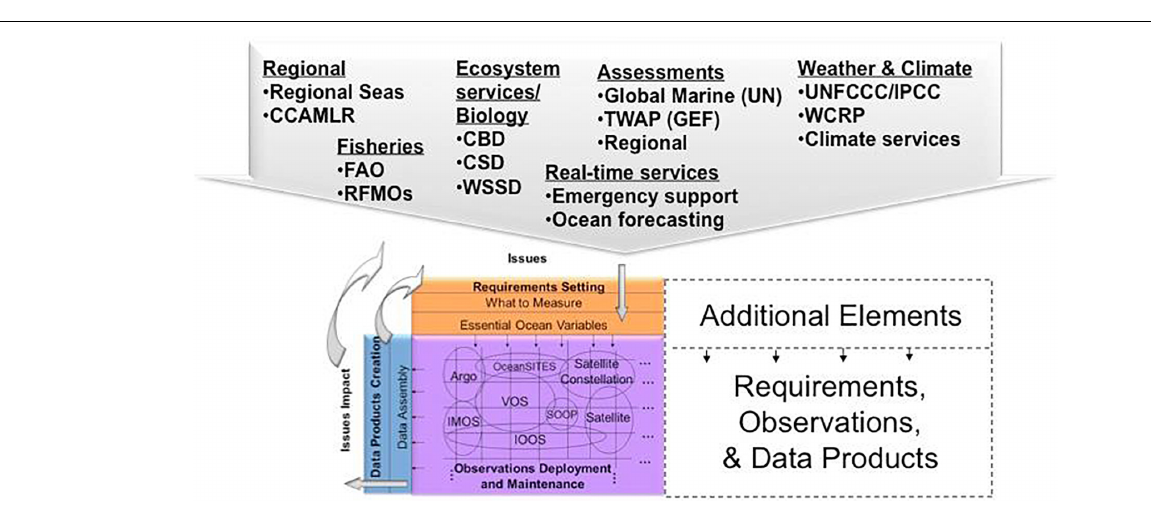
operational services, and marine ecosystem health.